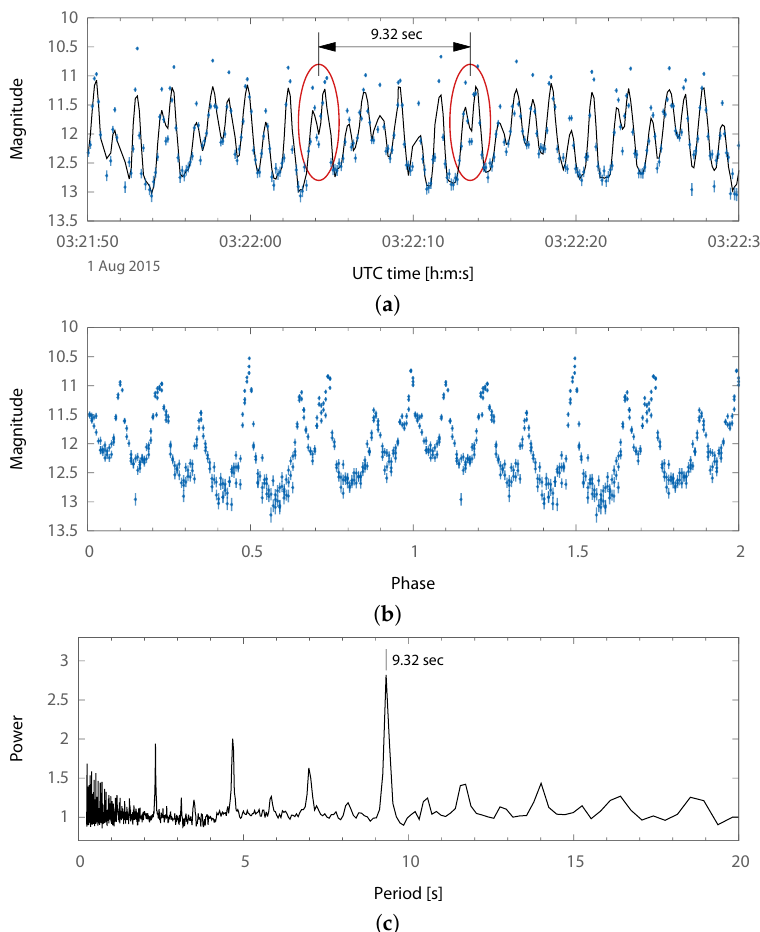
Figure 7. ( a ) light curve of the DICE-2 CubeSat (Spacetrack ID 37852) spinning at about 0.1Hz.